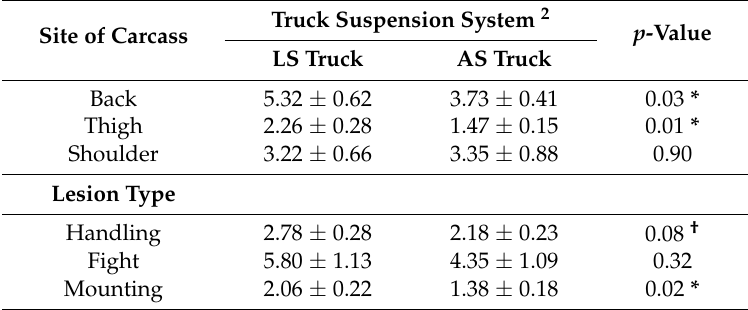
Table 4. Number 1 of carcass lesions (mean ± SE) in pigs transported by trucks with different suspension